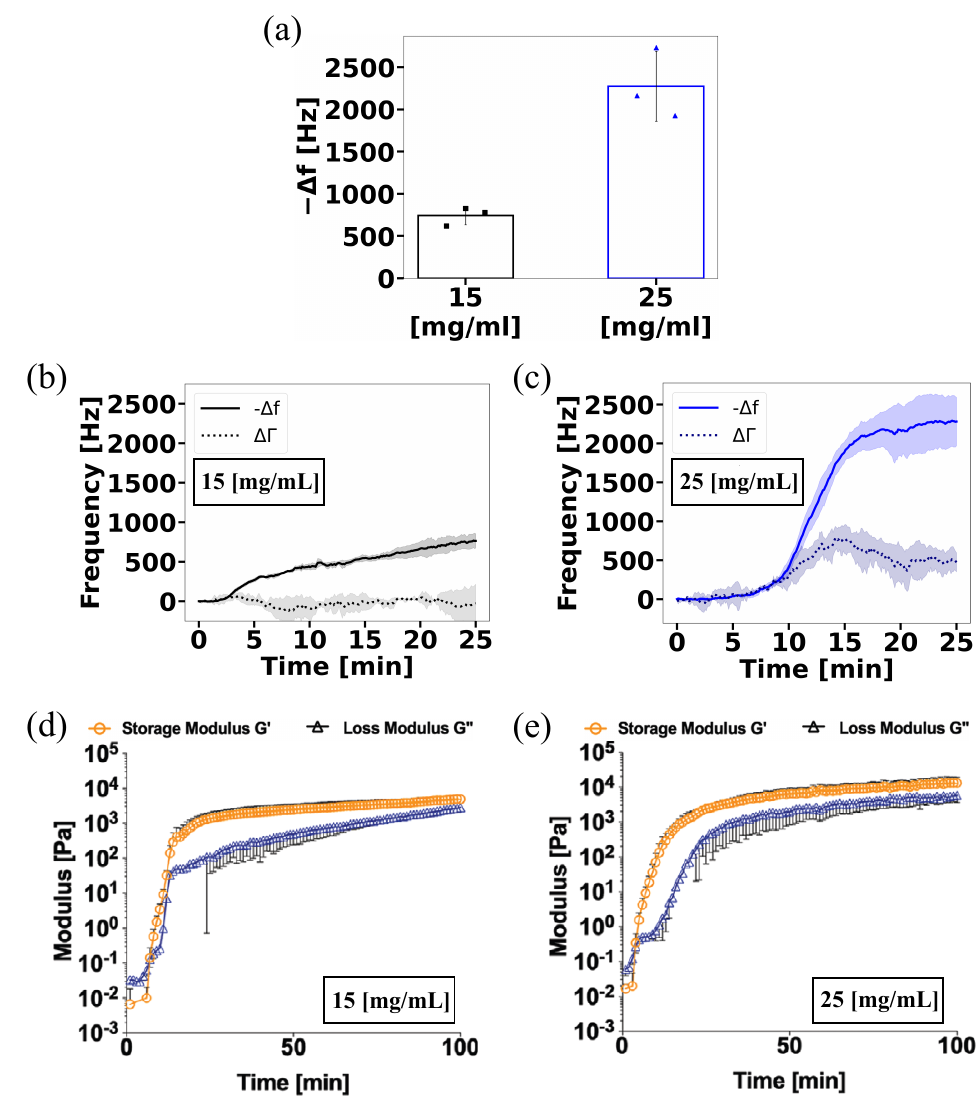
Figure 1. Characterisation of muc-gel formation. Using ViSQCT sensor @ 10MHz. ( a ) Comparison of ∆ f reached at the plateaulike stage after 25 min for 15 and 25 mg/mL muc-gels. ( b ) Time- dependent evaluation of ∆ f and ∆Γ for 15 mg/mL muc-gels. ( c ) Time-dependent evaluation of ∆ f and ∆Γ for 25 mg/mL muc-gels. The shaded area denotes the standard deviation as obtained from measurements of n = 3 independent samples. Rheological characterisation: ( d ) Time-dependent rheological evaluation for 15 mg/mL and ( e ) 25 mg/mL muc-gels. Rheological data were taken with permission from previously published work